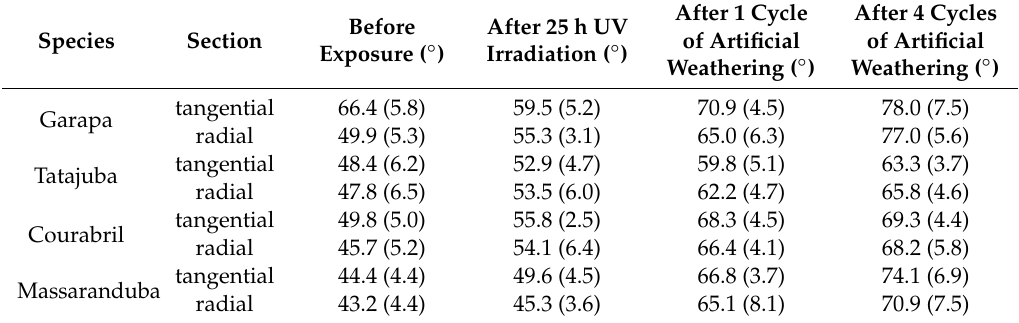
Table 5. Contact angles ( θ ) tested wood species before and after used weathering treatments (means and standard deviations in